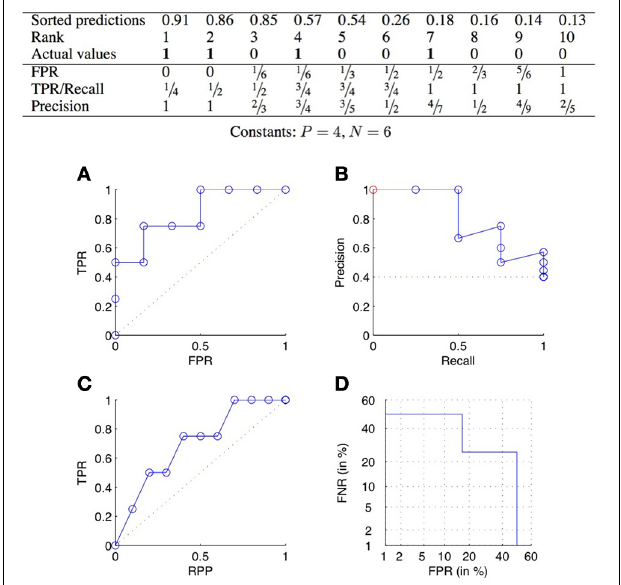
FIGURE 2 | ROC curve (A), precision-recall curve (B), lift chart (C), and DET curve (D) for the scores of the table above.